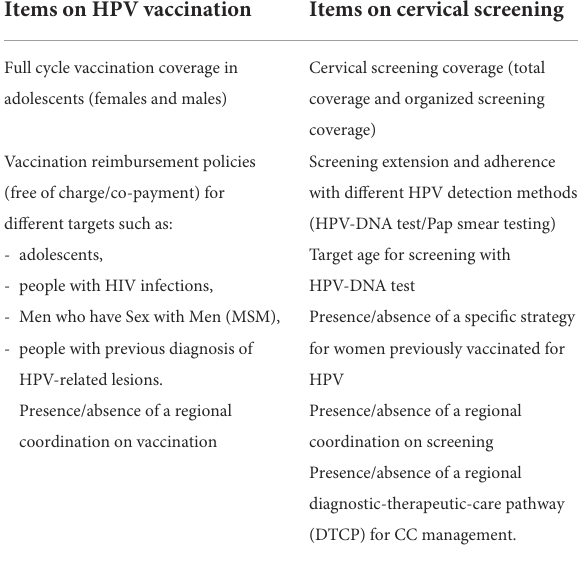
TABLE 1 Items on HPV vaccination and cervical screening collected in the mapping process of our study, for each Italian region. Items on HPV vaccination Items on cervical